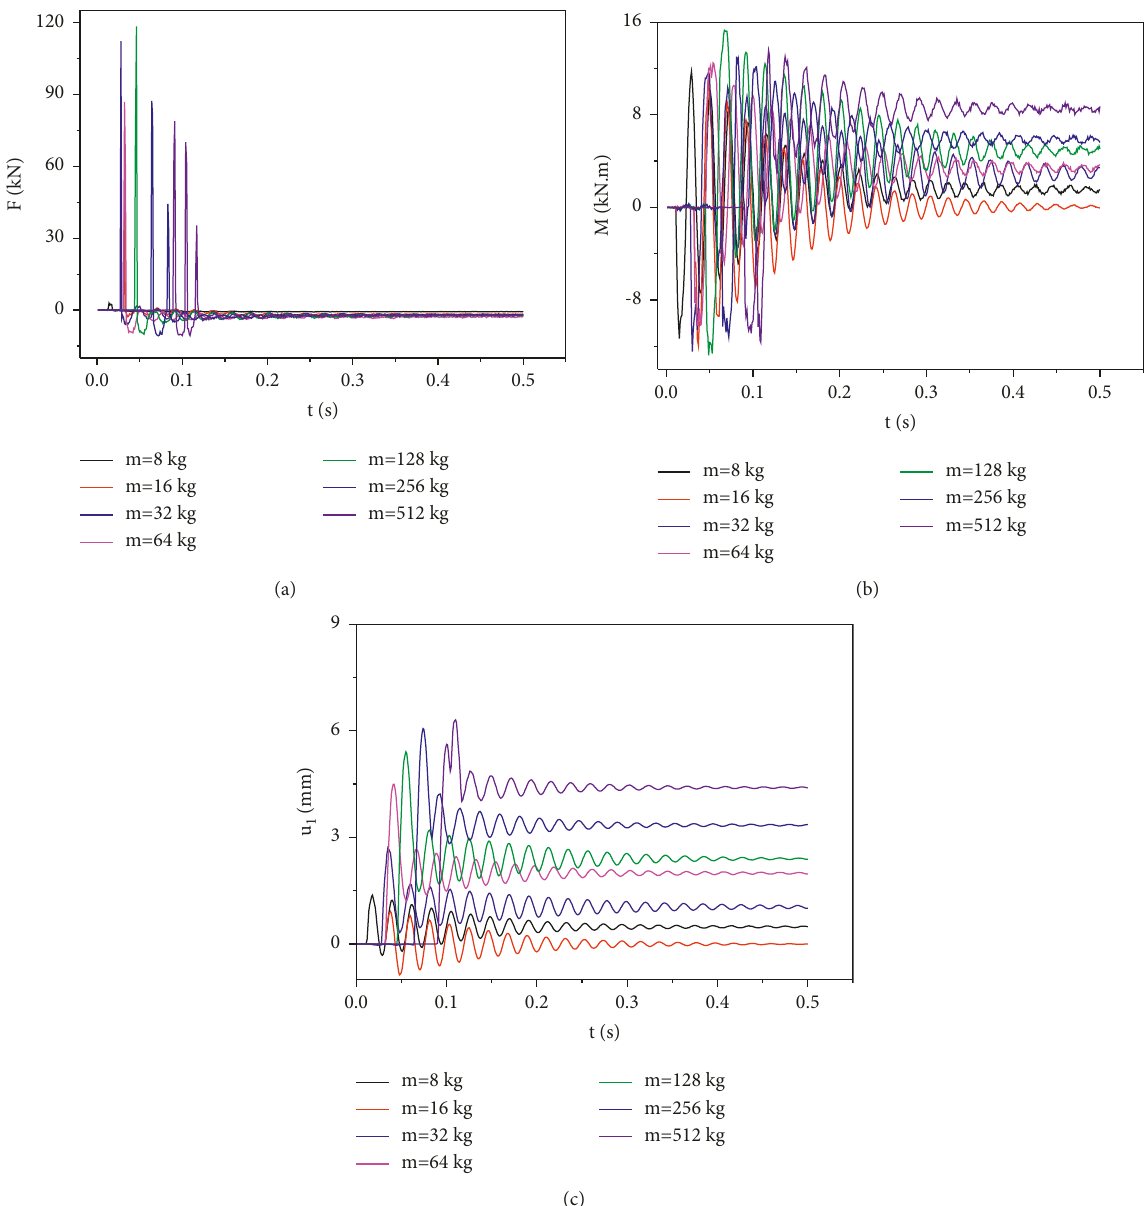
Figure 9: Dynamic response when Ek � 0.08kJ. (a) F- t ; (b) M- t ; (c) u1- t